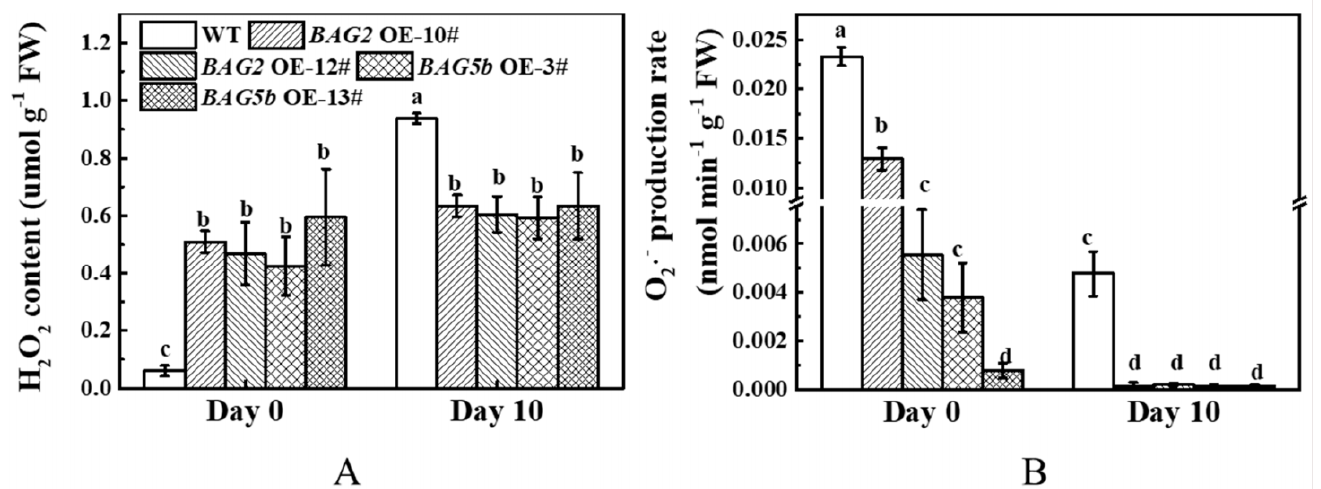
Figure 11. Effects of dark stress on ROS in WT, BAG2 OE, and BAG5b OE plants. ( A ): The H 2 O 2 content was detected in the fourth leaves after 0 d and 10 d of darkness. ( B ): The O 2 •− production rate was detected in the fourth leaves after 0 d and 10 d of darkness. Different letters indicate significant differences at P < 0.05. 10# and 12# represent 2 lines of BAG2 OE plants; 3# and 13# represent 2 lines of BAG5b OE plants; OE, overexpression; WT, wild